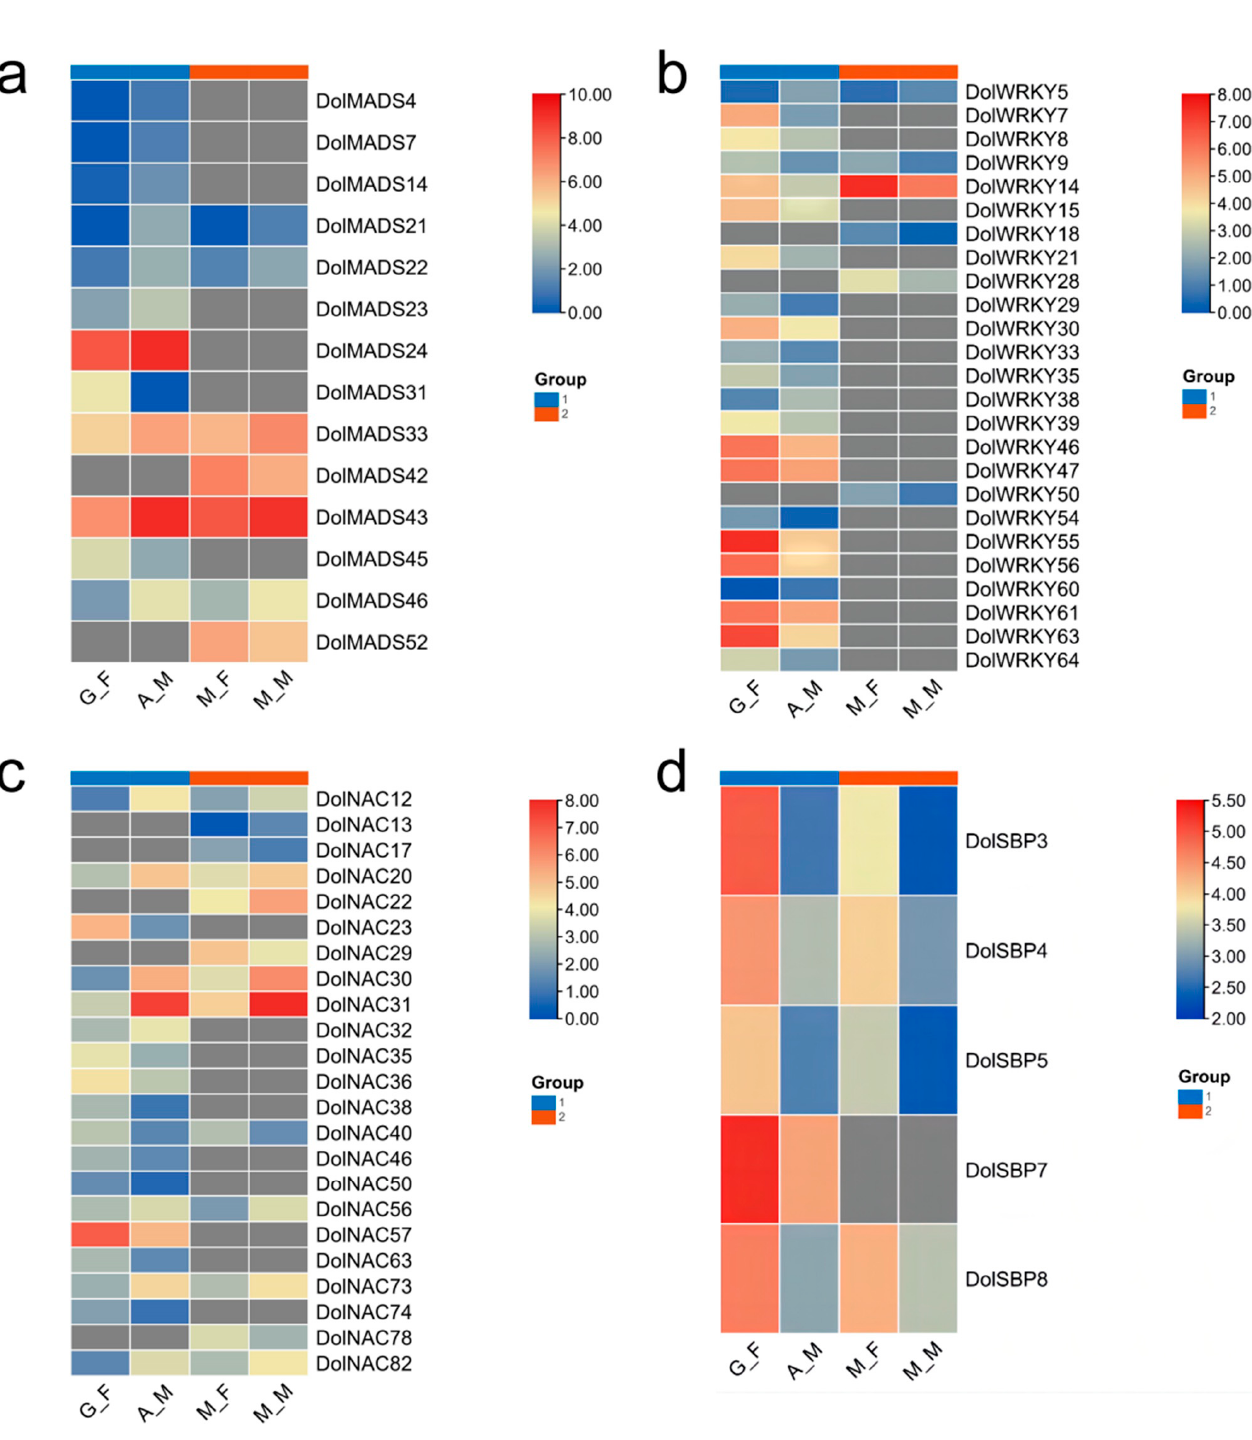
Figure 4. Expression profiles for ( a ) DolMADS s, ( b ) DolWRKY s, ( c ) DolNAC s, and ( d ) DolSBP s from different flower bud sex types. Log 2 (FPKM+1) values were used to plot the heatmap. The colour scale indicates the relative fold-change in gene expression, where red indicates high expression and blue indicates low expression. G_F: female flowers of gynoecious; A_M: male flowers of androecious; M_F: female flowers of monoecious; M_M: male flowers of monoecious. Gray indicates no differences within groups.